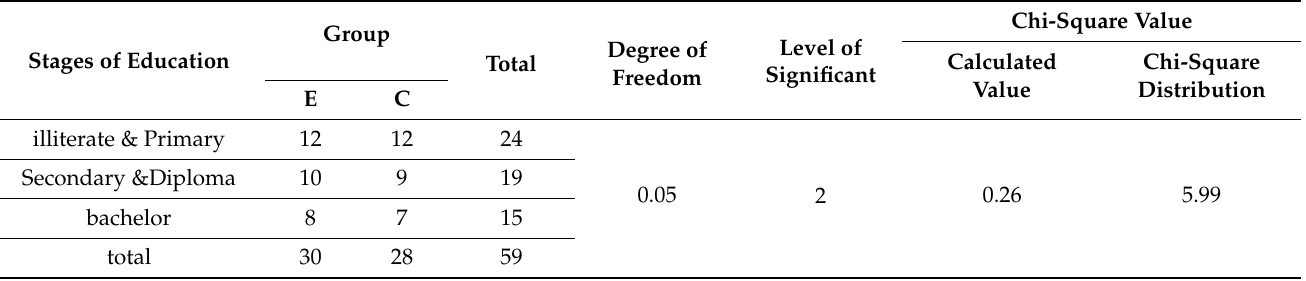
Table 6. Frequency and Chi-Square Value for the Level of Mothers Academic Attainment of Both